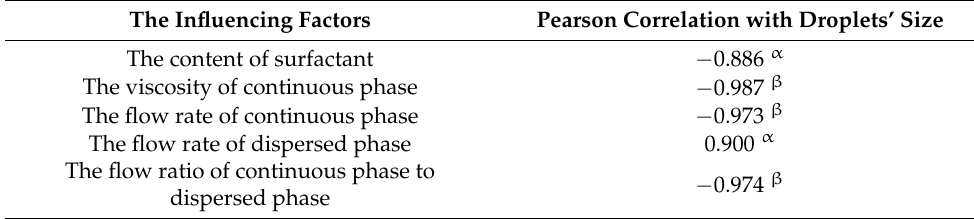
Table 2. Pearson correlation coefficient of influencing factors and droplet